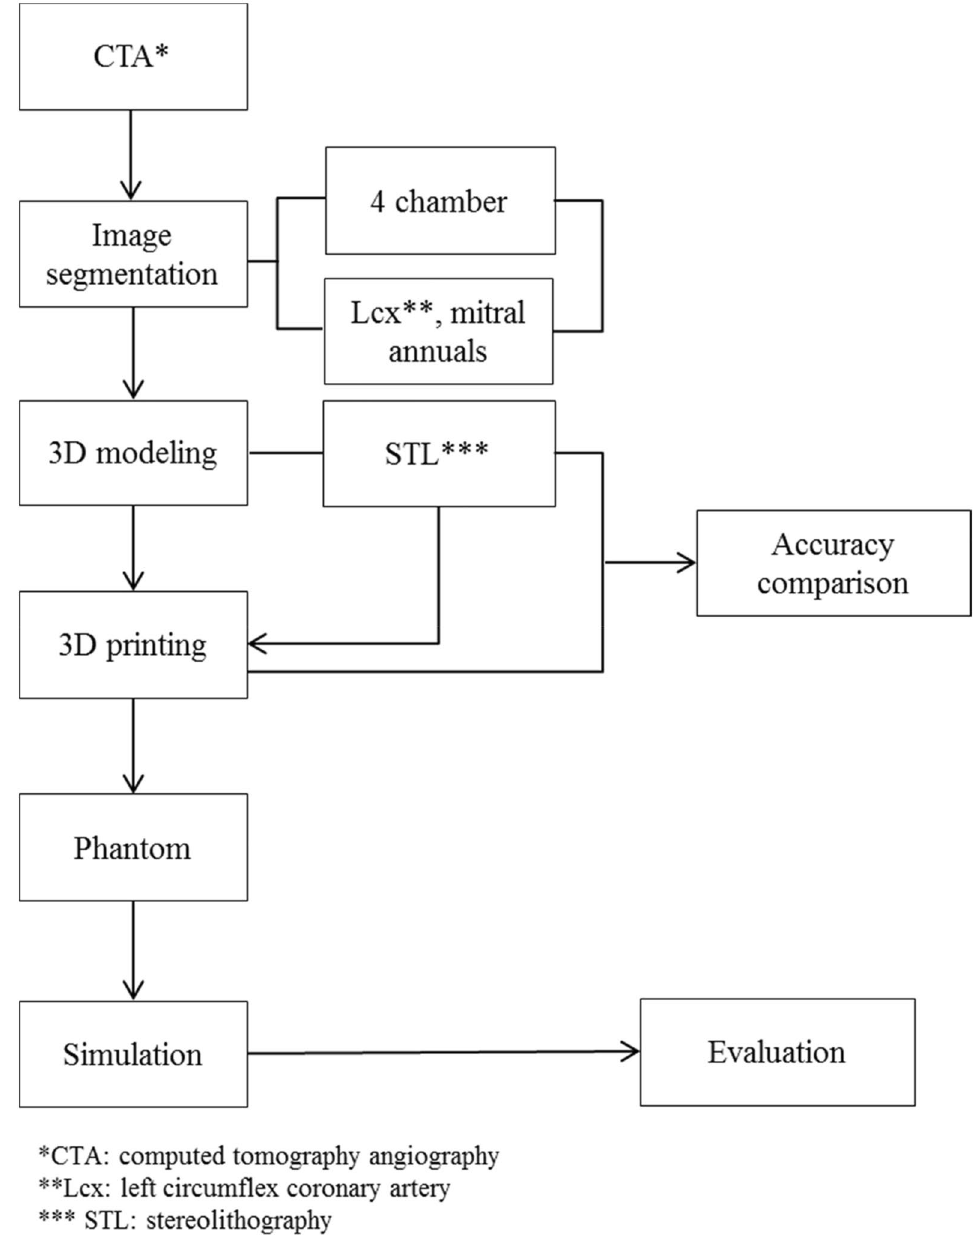
Figure 1. Overall workflow for developing rehearsal phantom for LAAO with 3D printing and medical images. 3D three-dimensional, CTA computed tomography angiography, LAAO left atrial appendage occlusion, Lcx left circumflex coronary artery, STL stereolithography.